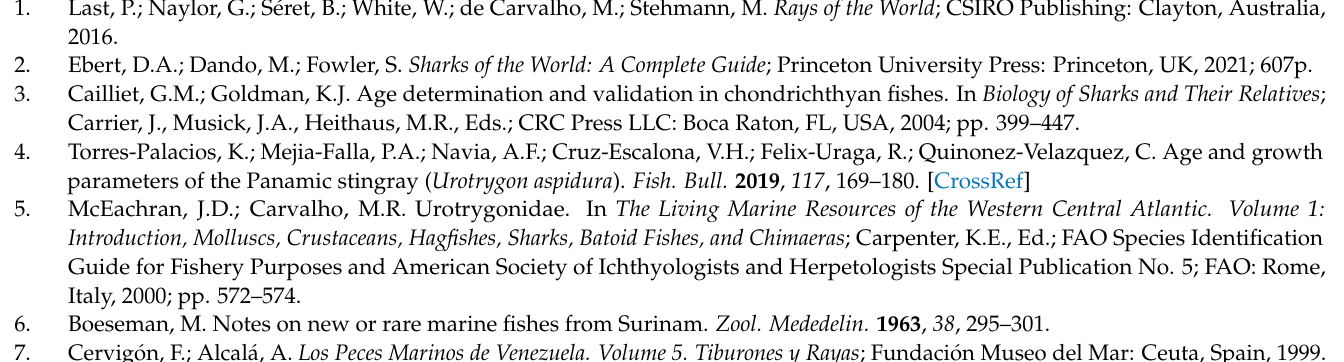
Figure S5: IMR between months for males of Urotrygon microphthalmum . G1: 2–4 bands; G2: 5–7; Table S1: Kruskal-Wallis test/post-hoc de Dunn from grouped sexes between months of Urotrygon microphthalmum ; Table S2: AIC from growth models for grouped sexes of Urotrygon microphthalmum